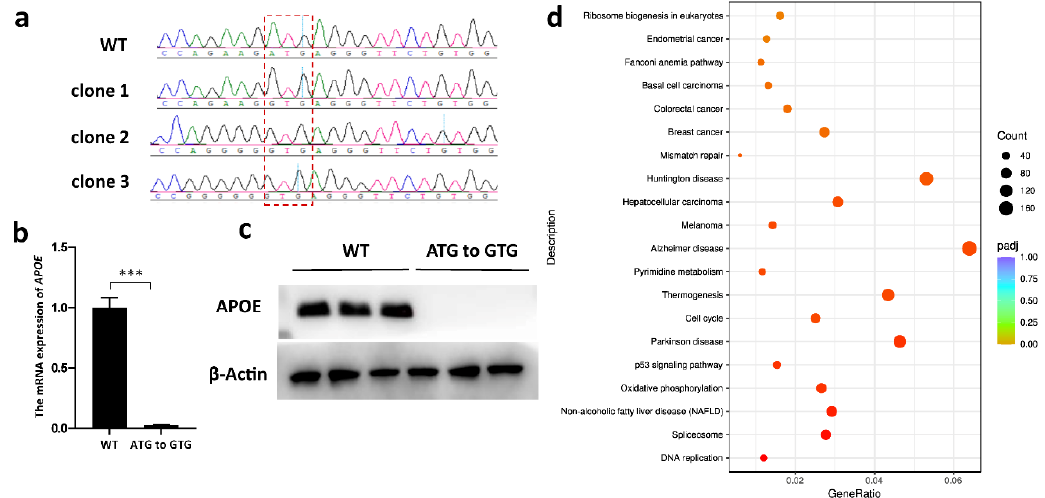
Figure 5 . Gene-expression detection and KEGG enrichment analysis in APOE start-codon-mutated PFFs. ( a ) Sequencing chromatograms of APOE -edited single-cell clones. The start codon is marked by the red frame. ( b ) The relative expression levels detected by qRT-PCR in three APOE -edited sin- gle-cell clones. *** p < 0.001, n = 3, independent replicates. ( c ) A Western blot showing the expressions of APOE in WT and APOE -edited PFFs. ( d ) The top 20 enriched KEGG pathways between the APOE - edited cell population and the WT PFFs. The x -axis represents the enrichment factor. The y -axis corresponds to the KEGG pathways. The colors of the dots represent the adjusted p -values, and the sizes of the dots represent the number of DEGs mapped to each reference pathway. R package ggplot2 (3.3.1) was performed to draw the bubble chart of the KEGG enrichment analysis.